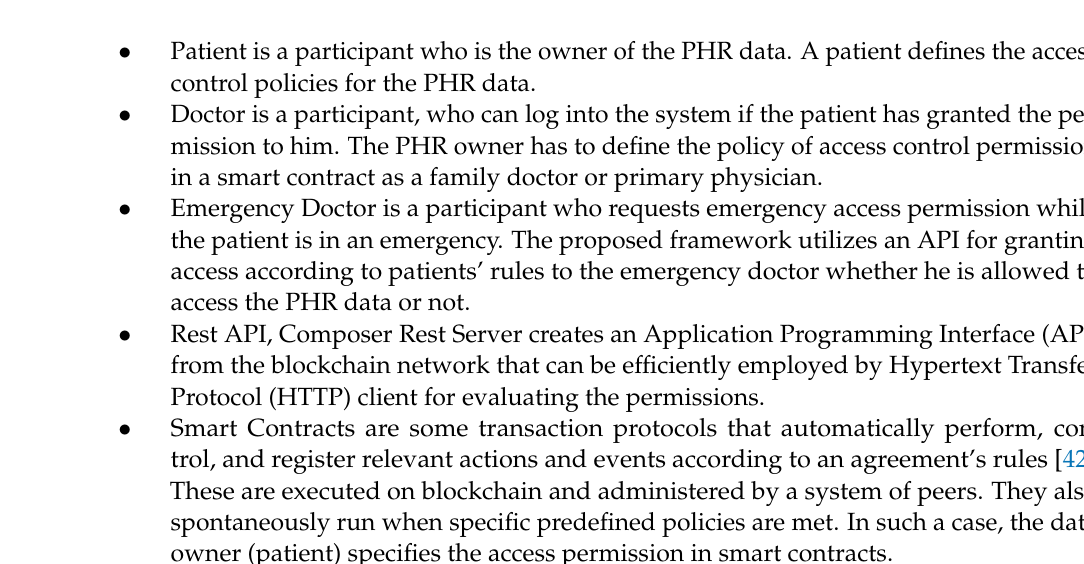
Figure 2. Proposed framework for personal health record (PHR) access control in Emergency.